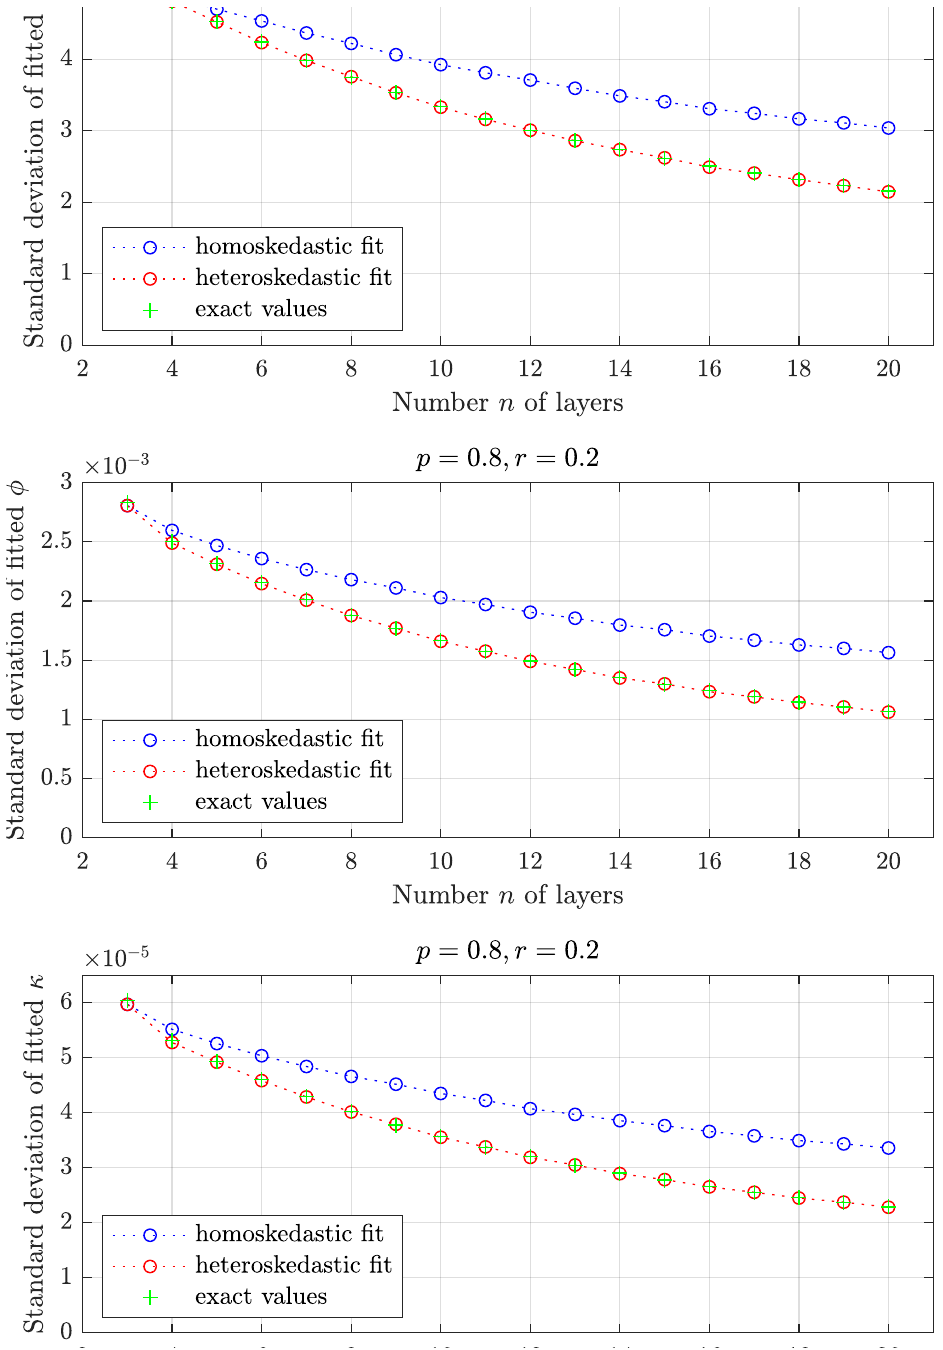
Figure 4. Top : estimated rms and exact standard deviation of the fitted angle Φ ; center : estimated rms and exact standard deviation of the fitted angle φ ; bottom : estimated rms and exact standard deviation of the fitted curvature κ , for p = 0.8, r = 0.2 in the range 3 ≤ n ≤